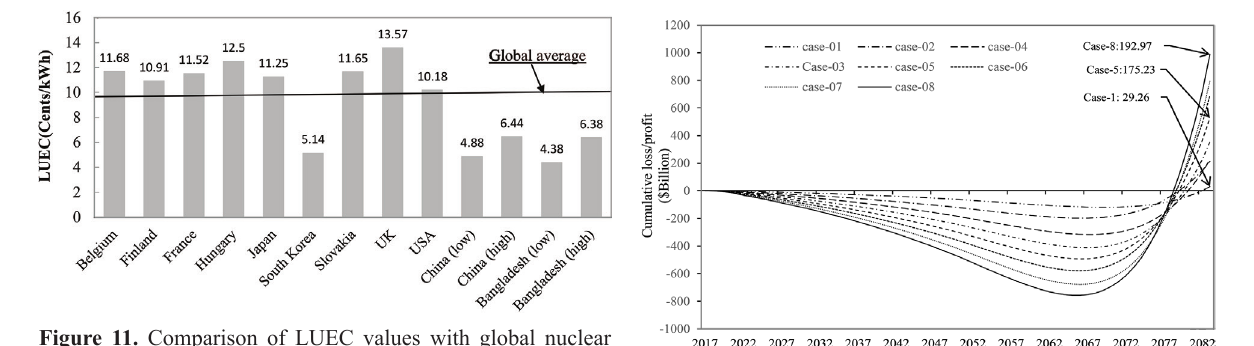
Figure 11. Comparison of LUEC values with global nuclear power generating countries (discount rate of 10% and PCF of 85% (OECD/NEA 2015).